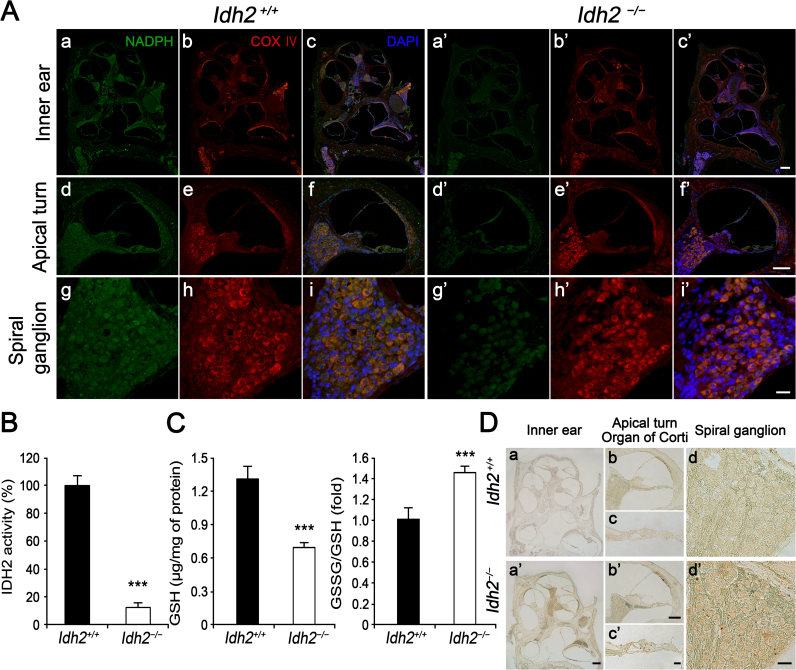
Redox status and oxidative damage observed in the inner ear ofIdh2−/−mice. Intracellular levels of NADPH and ROS accumulation were compared between Idh2+/+ and Idh2−/− mouse cochlea by immunofluorescence and DAB staining at 10 months of age. (A) Intracellular NADPH (green) levels in the inner ears of Idh2+/+ (n = 3) and Idh2−/− (n = 3) mice were compared at 10 months of age. COX IV (red) was used as a mitochondrial marker [32], and the nuclei were counterstained with DAPI (blue). Scale bars: 200 µm in (c′), 100 µm in (f′) and 20 µm in (i′). (B) The enzyme activity of IDH2 that produces NADPH was measured in the inner ear whole protein fractions (n = 3). (C) Total GSH level and the [GSSG]/[GSH] ratio were measured (n = 3). The values were presented as the fold change over the levels observed in Idh2+/+ mice. Data are shown as the means ± SEM. **p < 0.005, *** p < 0.001 (D) Oxidized levels of the inner ear sections from Idh2+/+ (n = 3) and Idh2−/− (n = 3) mice were analyzed using DAB staining. Scale bars: 200 µm in (a′), 100 µm in (b′) and 20 µm in (c′ and d′).